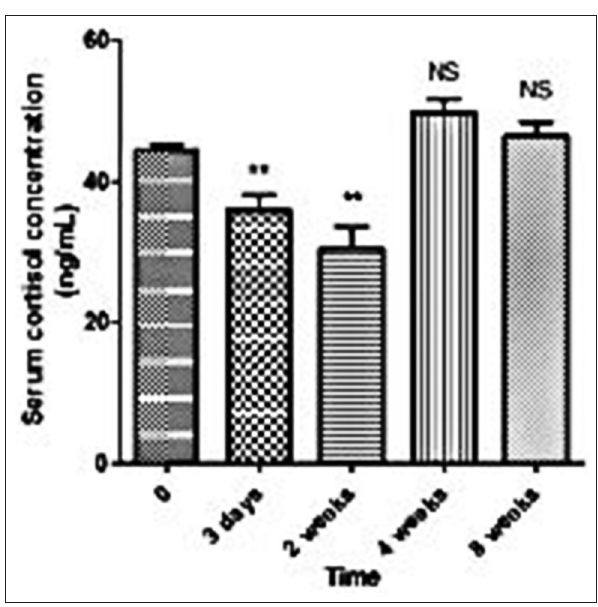
Figure-2: Variation in cortisol levels during a time